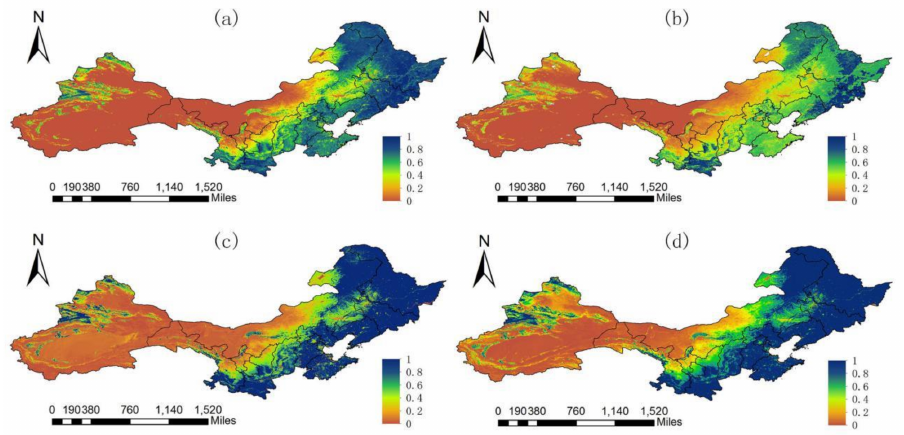
Figure 2. The spatial patterns of maximum FVC over the period 2001–2012 in northern China. ( a ) GLASS FVC; ( b ) TRAGL FVC; ( c ) GEOV1 FVC; ( d ) Li